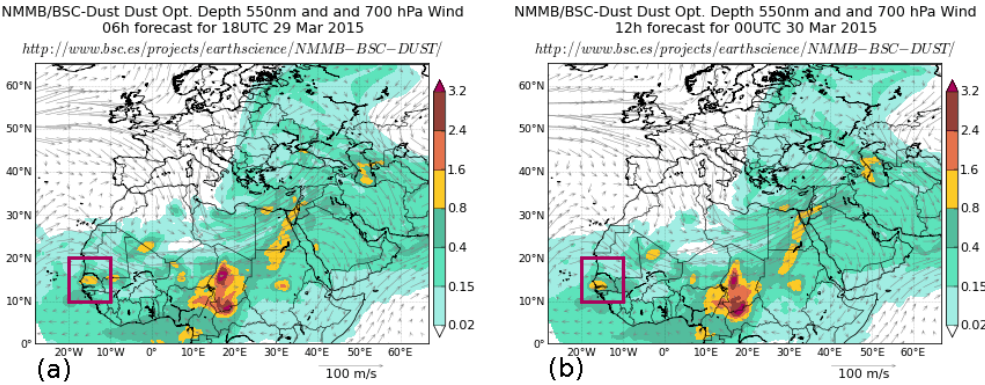
Figure 6. NMMB/BSC-Dust model over Africa and Europe on 29 March 2015. AOD values forecasted by the model ranged from 0.8 to 1.6 at 550nm. (a) 18:00 UTC, 29 March; (b) 00:00UTC, 30